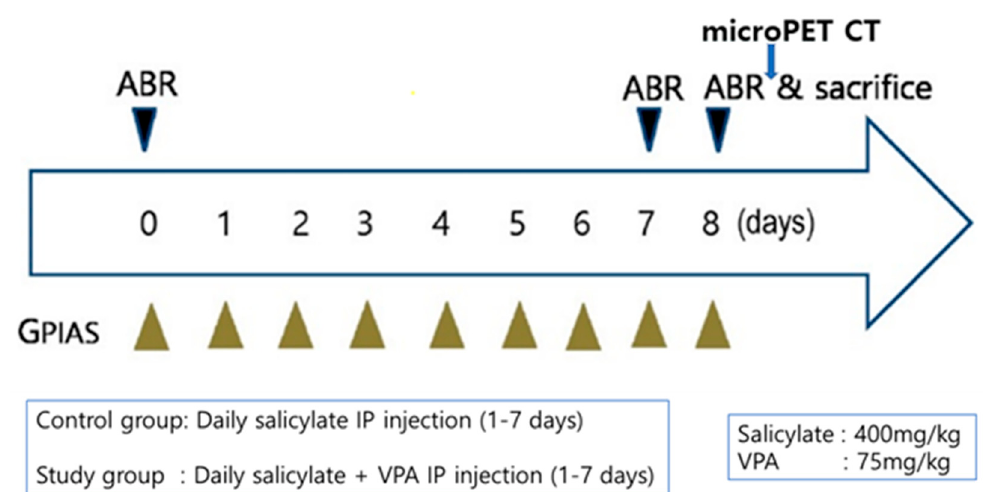
Figure 9. Flow chart of the in vivo